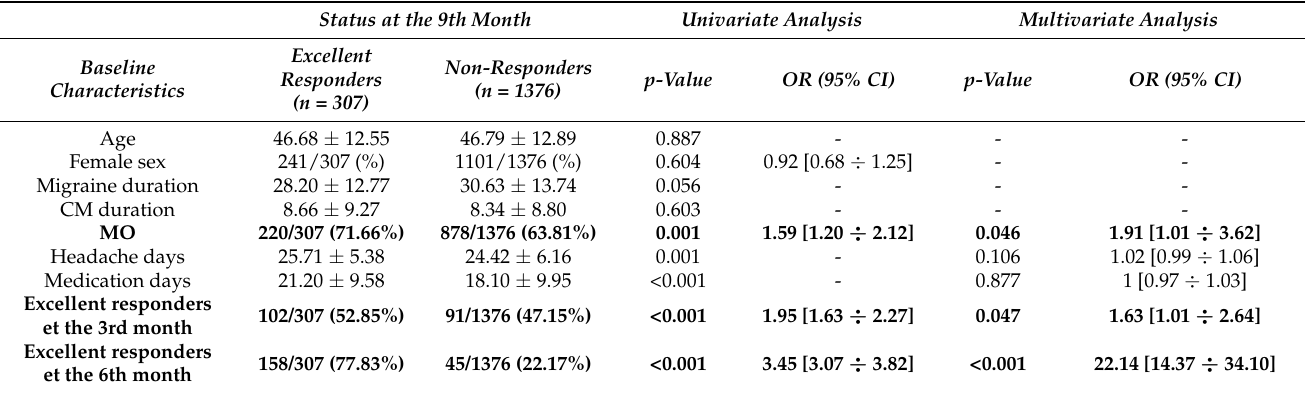
Table 2. Comparison between the percent-based excellent responders and the non-responders after the third BT-A